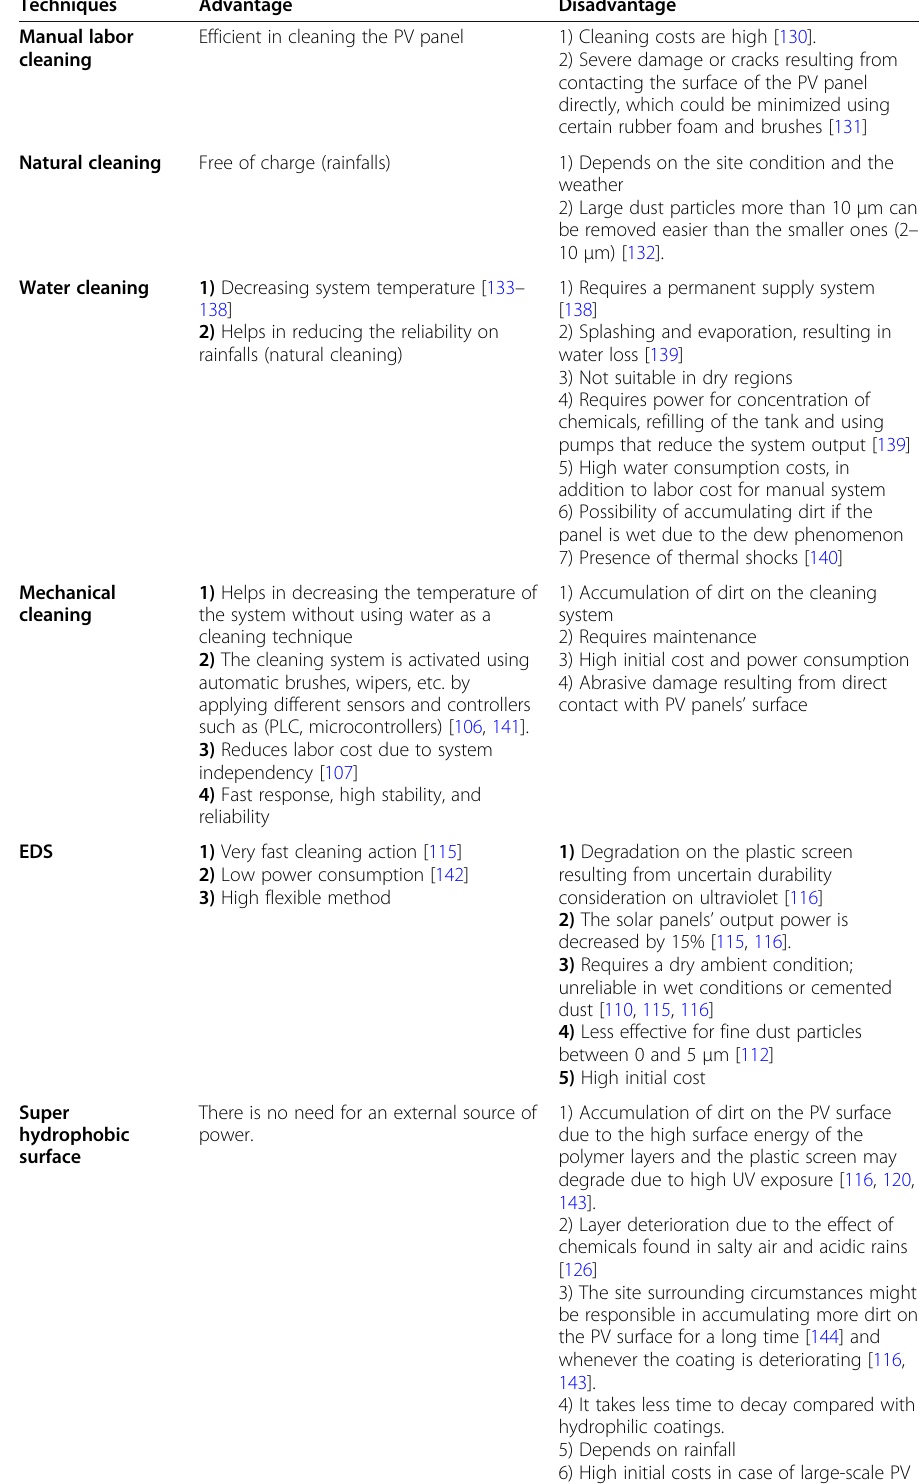
Table 3 Advantages and disadvantages of soiling mitigation